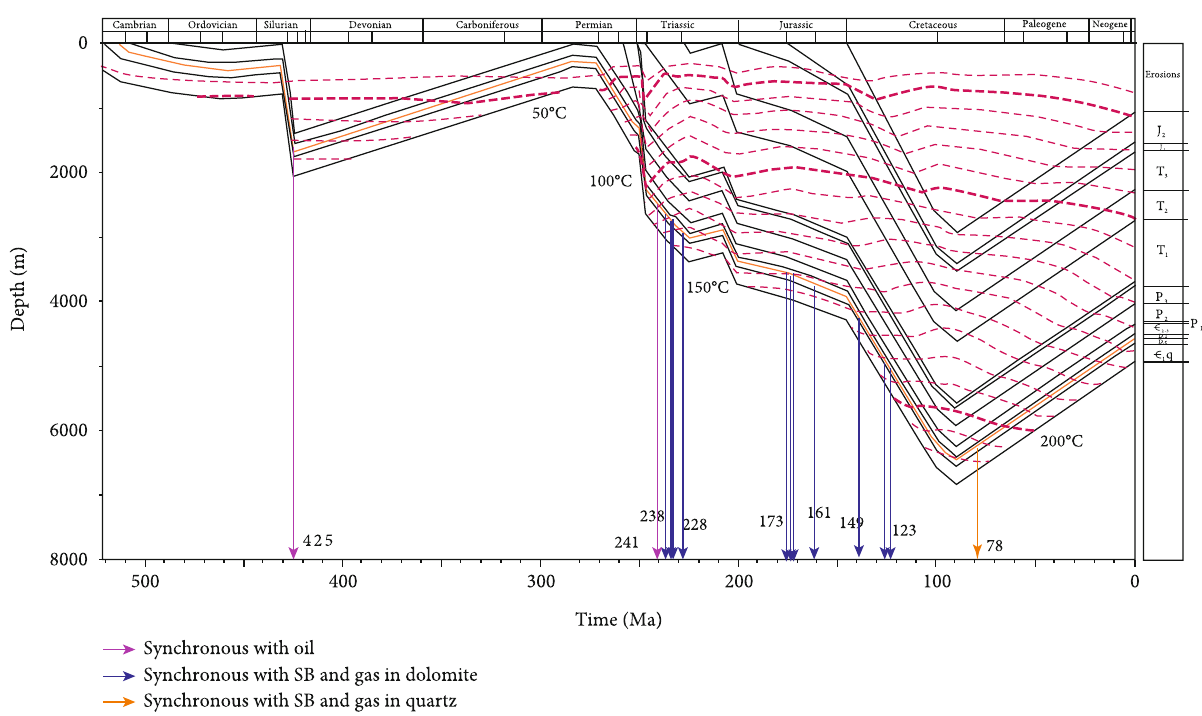
Figure 9: Graphical representation of the projected onto burial history curves to determine trapping times of hydrocarbon inclusions in Well MX20.